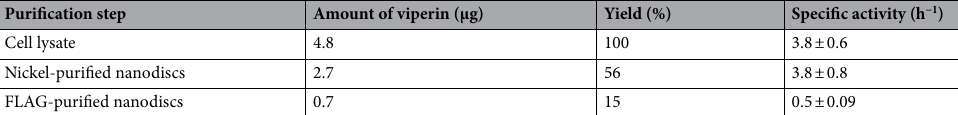
Table 1. Summary of yield and specific activity (calculated as a turnover number) for the purification of viperin from HEK293T lysate utilizing nanodiscs. The amount of viperin was quantified by immunoblotting as described in the text. The amount of viperin and percentage yield are values obtained from one representative purification. The specific activity is calculated as an average determined from three